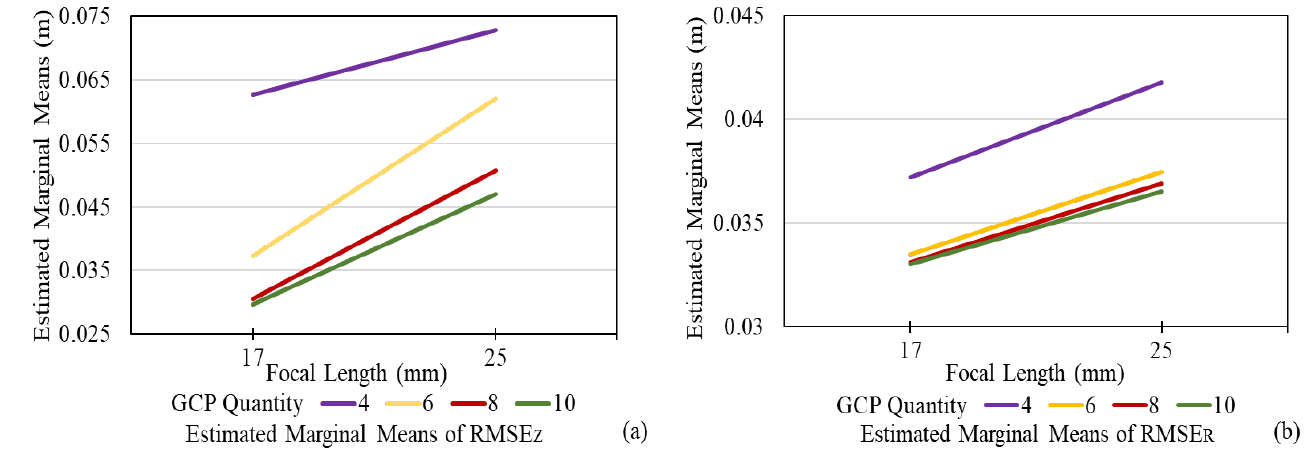
Figure 12. Interaction between Flight Height and Image Overlap; ( a ) RMSE Z ; ( b ) RMSE R.